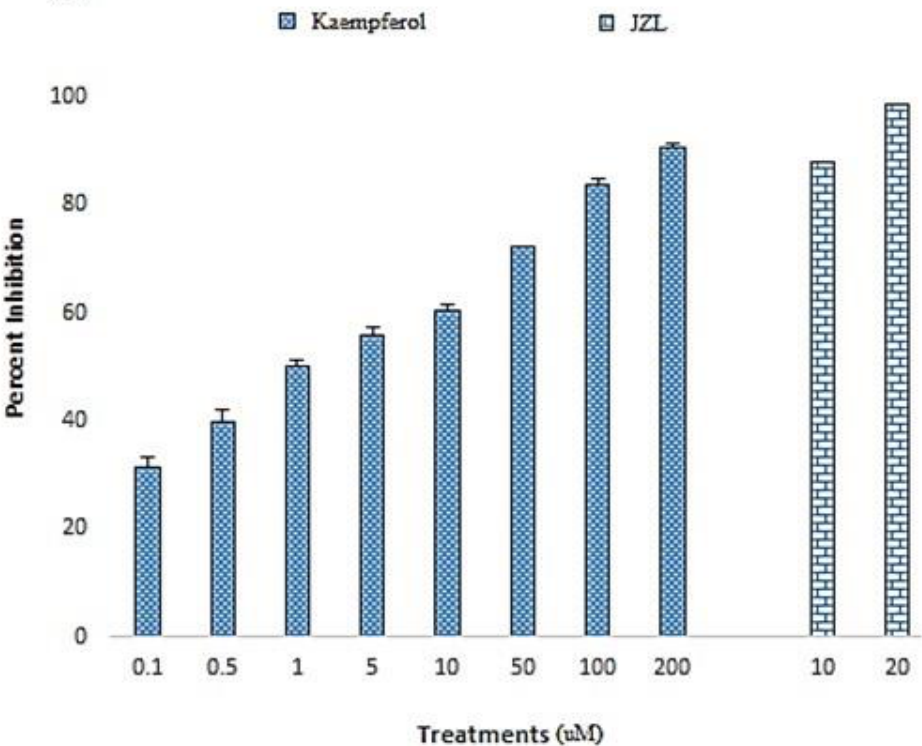
Figure 1. Inhibition of the FAAH enzyme by kaempferol . The figure depicts the dose-dependent inhibition of FAAH by kaempferol (0.1–200 µ M) and standard JZL165 (10 and 20 µ M). Data are shown inhibition of FAAH by kaempferol (0.1–200 µM) and standard JZL165 (10 and 20 µM). Data are shown as the mean ± S.E.M of percent as the mean ± S.E.M of percent inhibition.